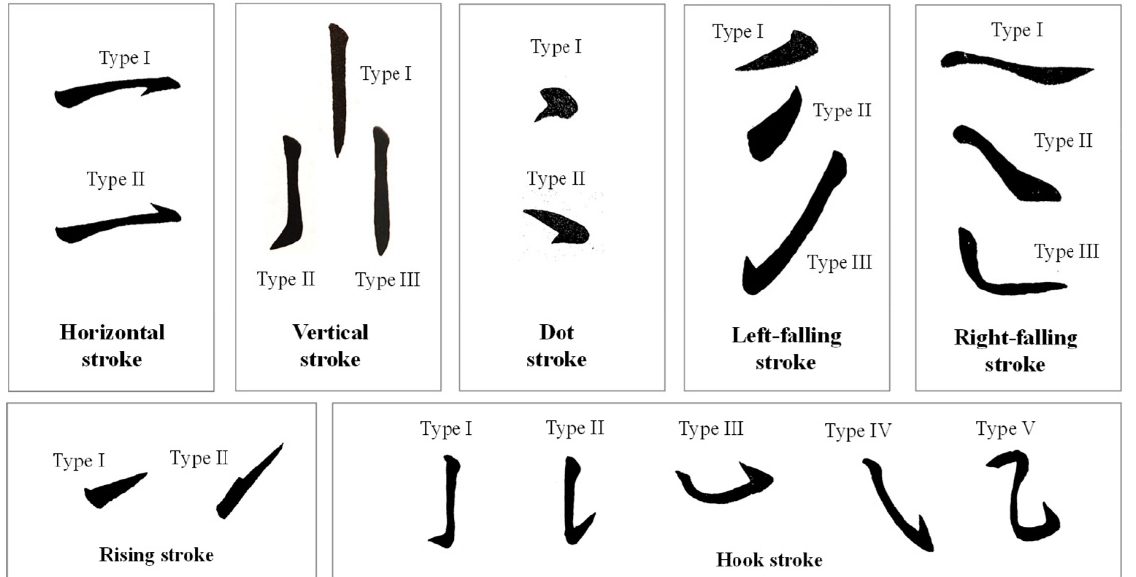
Figure 1. Illustration of calligraphy brushwork of the running script. The Chinese brush can be manipulated by combining a finger grip with a wrist position. In practice, there are many different finger grips, such as applying two fingers to pinch the brush handle, or placing four fingers together vertically on the side of the brush handle with the thumb pressing forward from the back. For general users, the three-finger grip and five-finger grip are the most popular and commonly used. The wrist position can be divided into four types: rested, cushioned, suspended, and raised. Thus, by combining different wrist positions and finger grips, numerous Chinese brush manipulation combinations can be produced. At present, a consensus on the best way to manipulate the Chinese brush for beginners of CCH has not yet been